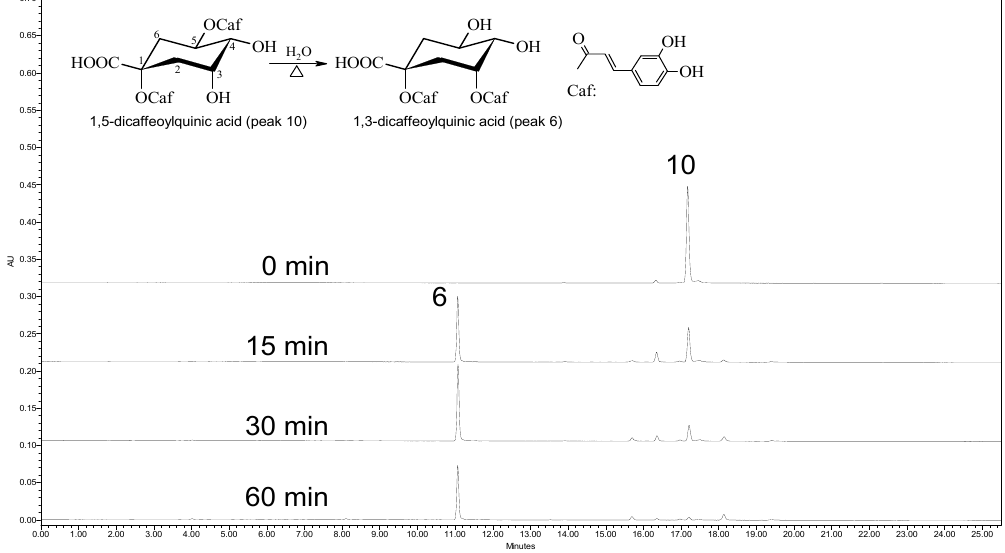
Figure 2. The chromatogram of 1,5-dicaffeoylquinic acid aqueous solution after boiling